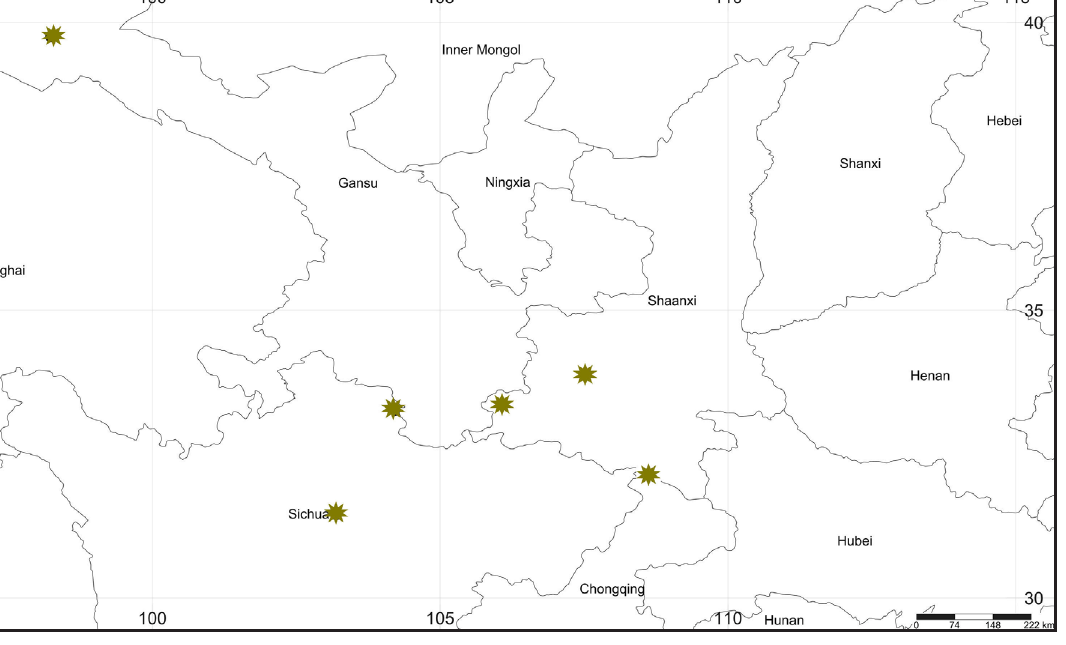
Fig. 7. Distribution map of Synchroa chinensis Nikitsky, 1999 from